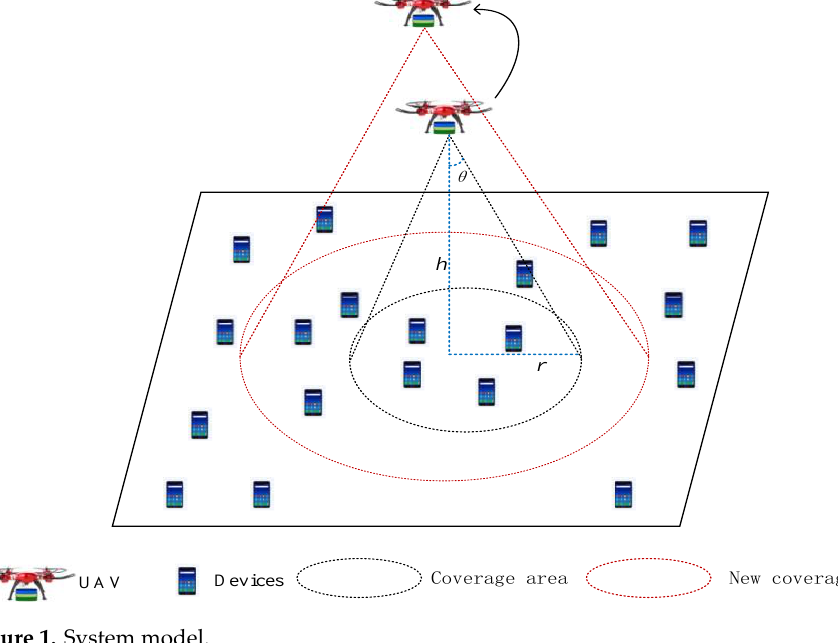
Figure 1. System model.